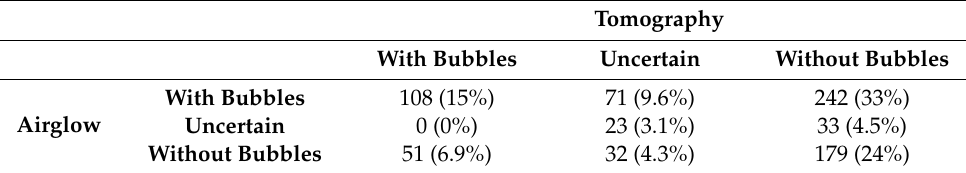
Table 3. Confusion matrix showing the number and percentage of plasma bubbles detected by the tomographic reconstruction and optical instruments in the observatory of Cachoeira